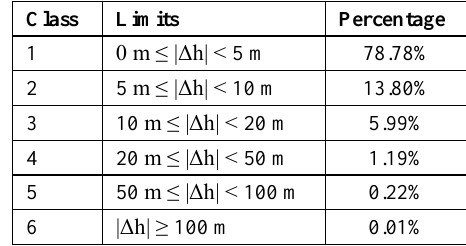
Table 2. Differences between LR Lombardy DTM and HR